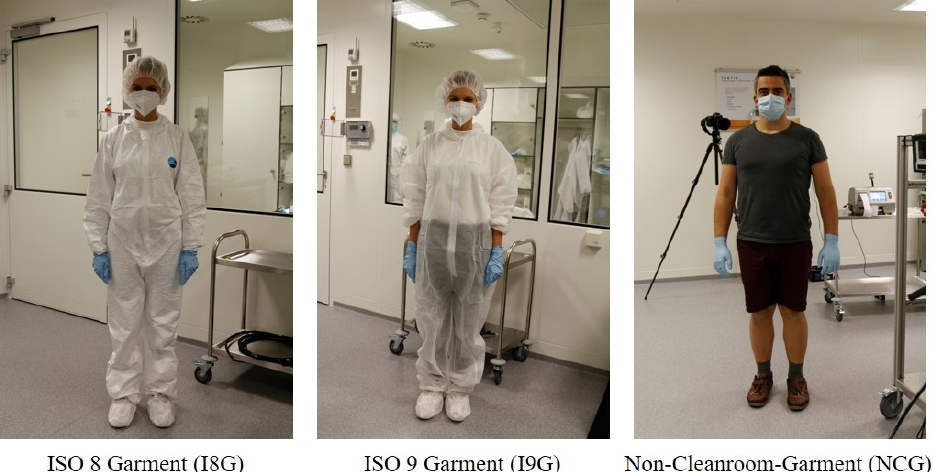
Figure 1. Different garments used during the experimental study.